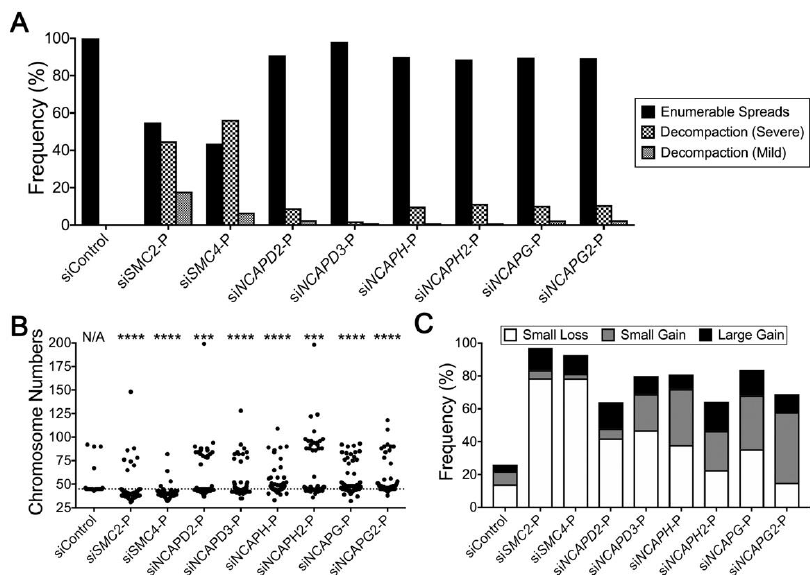
Figure 4. Reduced condensin gene expression induces aberrant numerical and decompaction phenotypes in HCT116. ( A ) Bar graph presenting the frequency of enumerable and chromosome decompaction phenotypes (severe and mild) following gene silencing. ( B ) Dot plot depicting an overall increase in chromosome number heterogeneity following condensin gene silencing relative to siControl. The horizontal line identifies the modal chromosome number of HCT116. KS tests reveal statistically significant differences in the cumulative distribution frequencies of chromosome numbers relative to siControl (***, p < 0.001; ****, p < 0.0001). ( C ) Bar graph depicting overall increases in the frequency of aberrant chromosome numbers following condensin gene